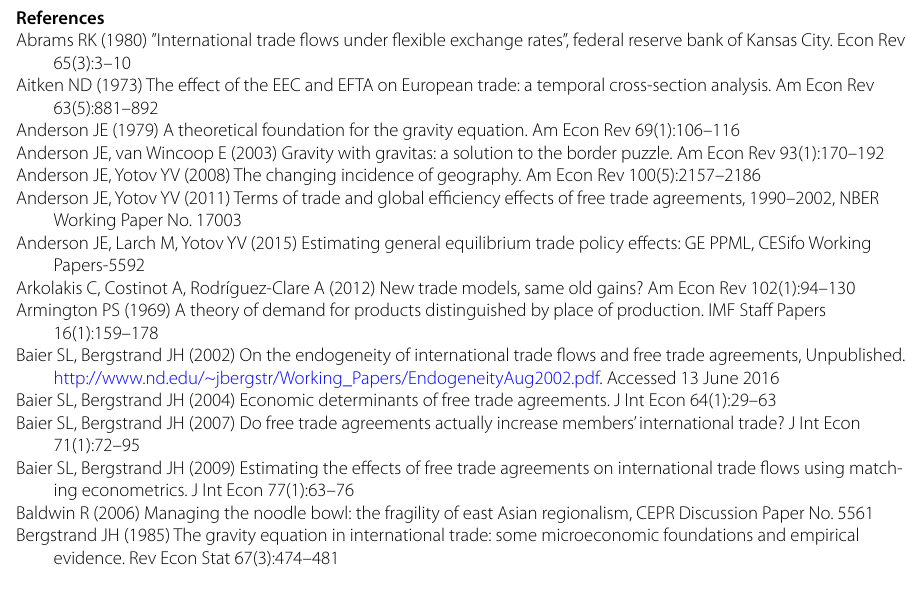
Table 12 Alternative approach to evaluate counterfactual effect of SAFTA